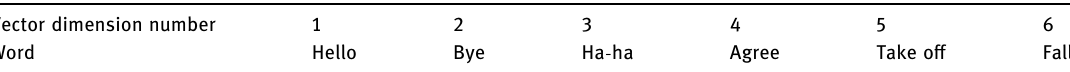
Table 1: Vocabulary of six - dimensional vector Vector dimension